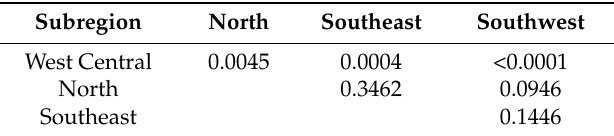
Table 9. One-tailed p values from pairwise Mann-Whitney tests of difference in abundance in long-term monitoring units 1998–2015 between subregions at Buena Vista Grassland. N = 18 years for all tests. Significant values ( p < 0.025) are shown in boldfaced italics.